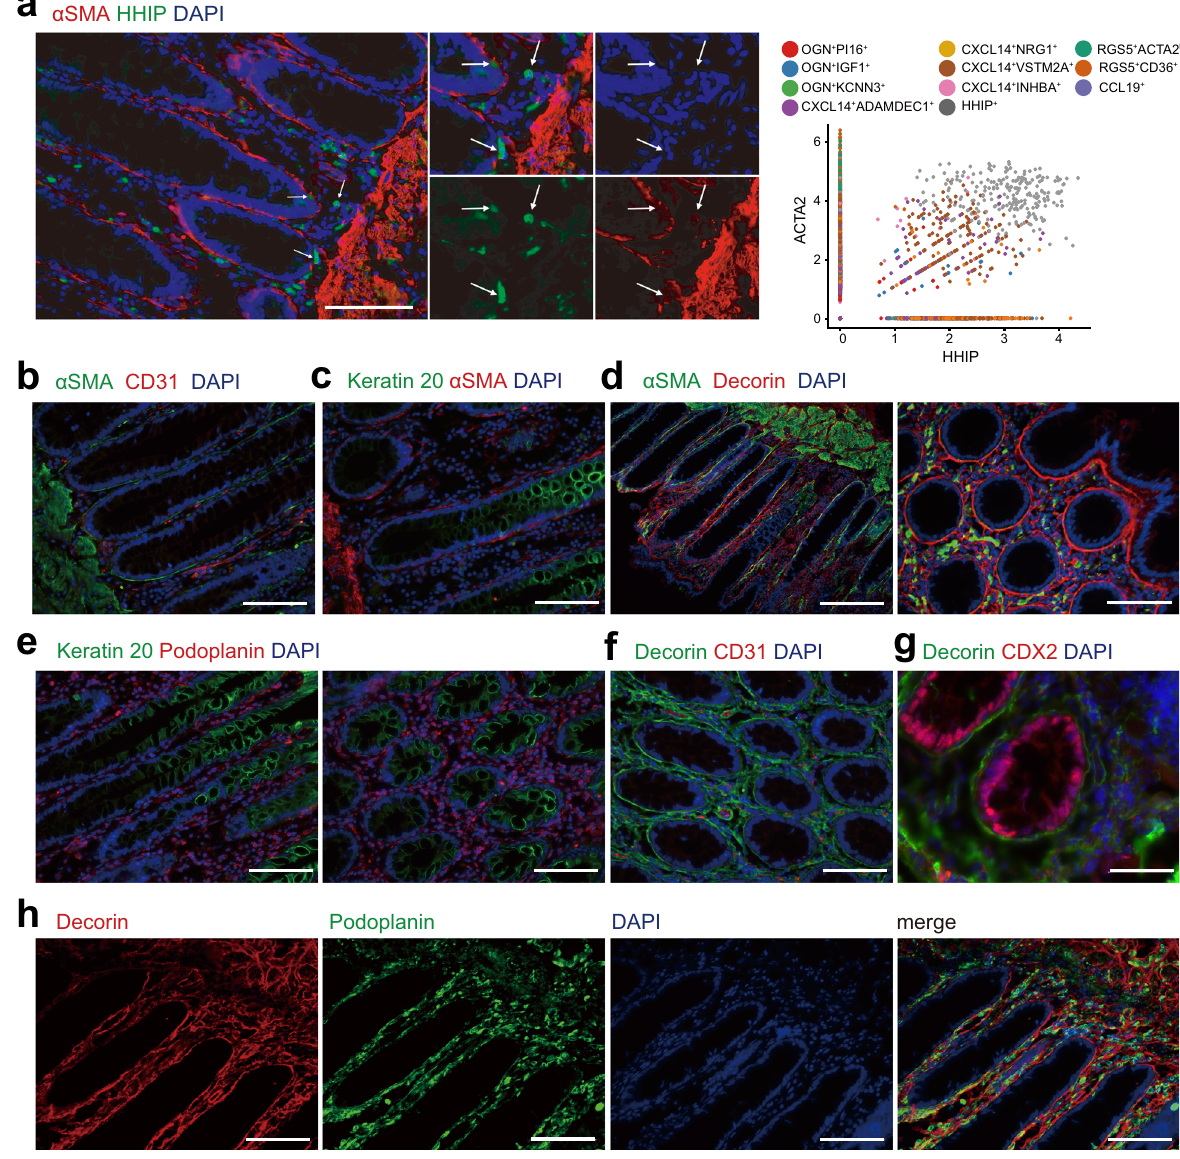
Fig. 5 Immuno fl uorescence staining of fi broblasts and myo fi broblasts in human colonic mucosa. a Left: HHIP + fi broblasts in normal mucosa labeled by α - SMA (red) and HHIP (green). Arrows point at the cells expressing both markers. Scale bar indicates 100 μ m. Right: The correlation between ACTA2 and HHIP expression in each cell. Fibroblasts in the HHIP + cluster were double positive for both ACTA2 and HHIP. b Double labeling for α -SMA (green) and CD31 (red). Scale bar indicates 100 μ m. c Double labeling for α -SMA (red) and Keratin 20 (green). Scale bar indicates 100 μ m. d Double labeling for fi broblast markers α - SMA (green) and Decorin (red) in the colonic mucosa. Vertical section (left) and cross section (right) of the colonic mucosa. Scale bar indicates 200 μ m (left) and 100 μ m (right). e Double labeling for Keratin 20 (green) and Podoplanin (red). Vertical section (left) and cross section (right) of the colonic mucosa. Scale bar indicates 100 μ m. f Doublelabelingfor Decorin (green) and CD31(red).Scalebar indicates100 μ m. g Double labeling for Decorin(green)and CDX2(red)in the colonic mucosa. Scale bar indicates 50 μ m. h Double labeling for Decorin (red) and Podoplanin (green). Each fl uorescent channel was displayed separately. Scale bar indicates 100 μ m. DAPI: 4 ′ ,6-diamidino-2-phenylindole, blue- fl uorescent labeling nuclei; α -SMA, α -smooth muscle actin, encoded by ACTA2 gene; Decorin, encoded by DCN gene. Podoplanin encoded by PDPN. HHIP, Hedgehog interacting protein, encoded by HHIP gene. Keratin 20, labeling mature enterocytes. CDX2, Caudal Type Homeobox 2, an intestinal speci fi c transcription factor labeling intestinal epithelial and cancer cell. CD31, Platelet and Endothelial Cell Adhesion Molecule 1, labeling endothelial cells. CD45, Protein Tyrosine Phosphatase Receptor Type C, labeling immune